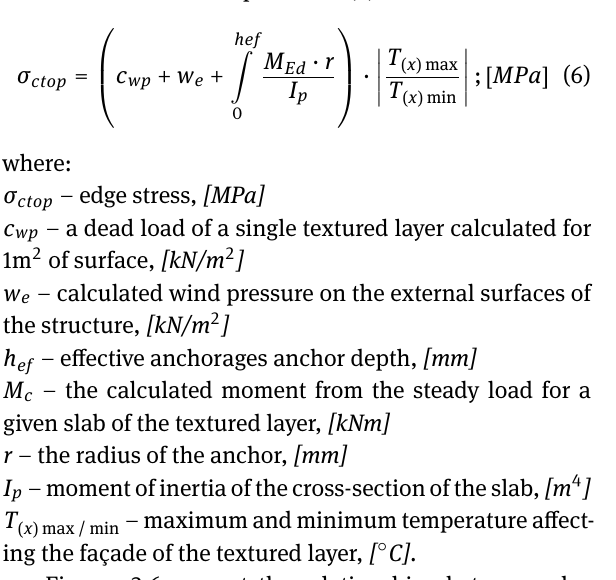
Figure 5: Dependency edge stress – adhesion stress for M8 ÷ M30 anchors in a balcony slab.